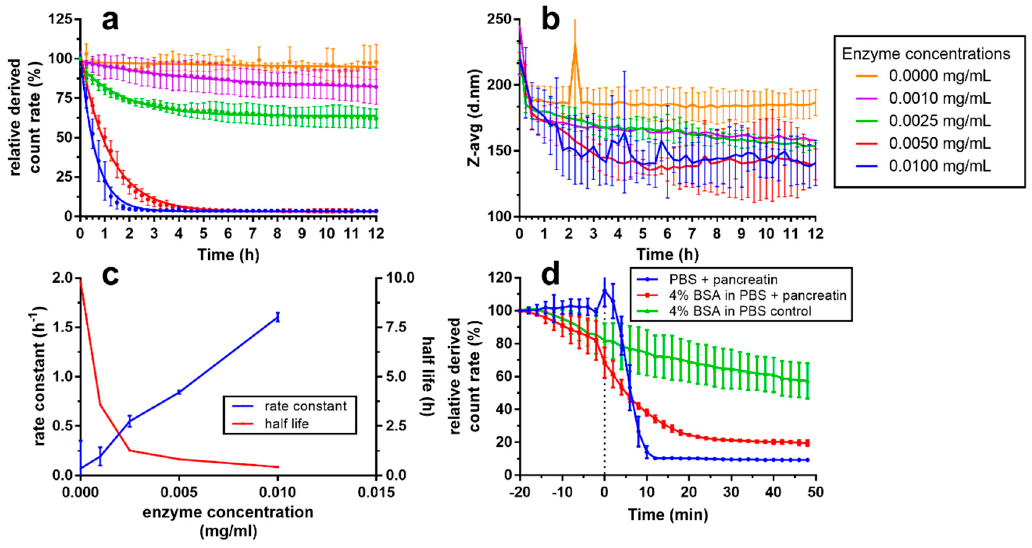
Figure 5. Enzymatic degradation of fluorescently labelled NCs using pancreatin measured by ( a ) derived count rate relative to initial value and ( b ) Z-avg particle size as measured by DLS. ( c ) Rate constant and half-life in dependence of enzyme concentration calculated from ( a ). ( d ) Degradation of CS NCs as diluted 1:100 in PBS and PBS with 4% bovine serum albumin as measured by derived count rate relative to initial values. Pancreatin was added at timepoint zero (dotted line) to a final concentration of 0.1 mg/mL for non-control samples. All measurements were performed at 37 °C ( n = 3).